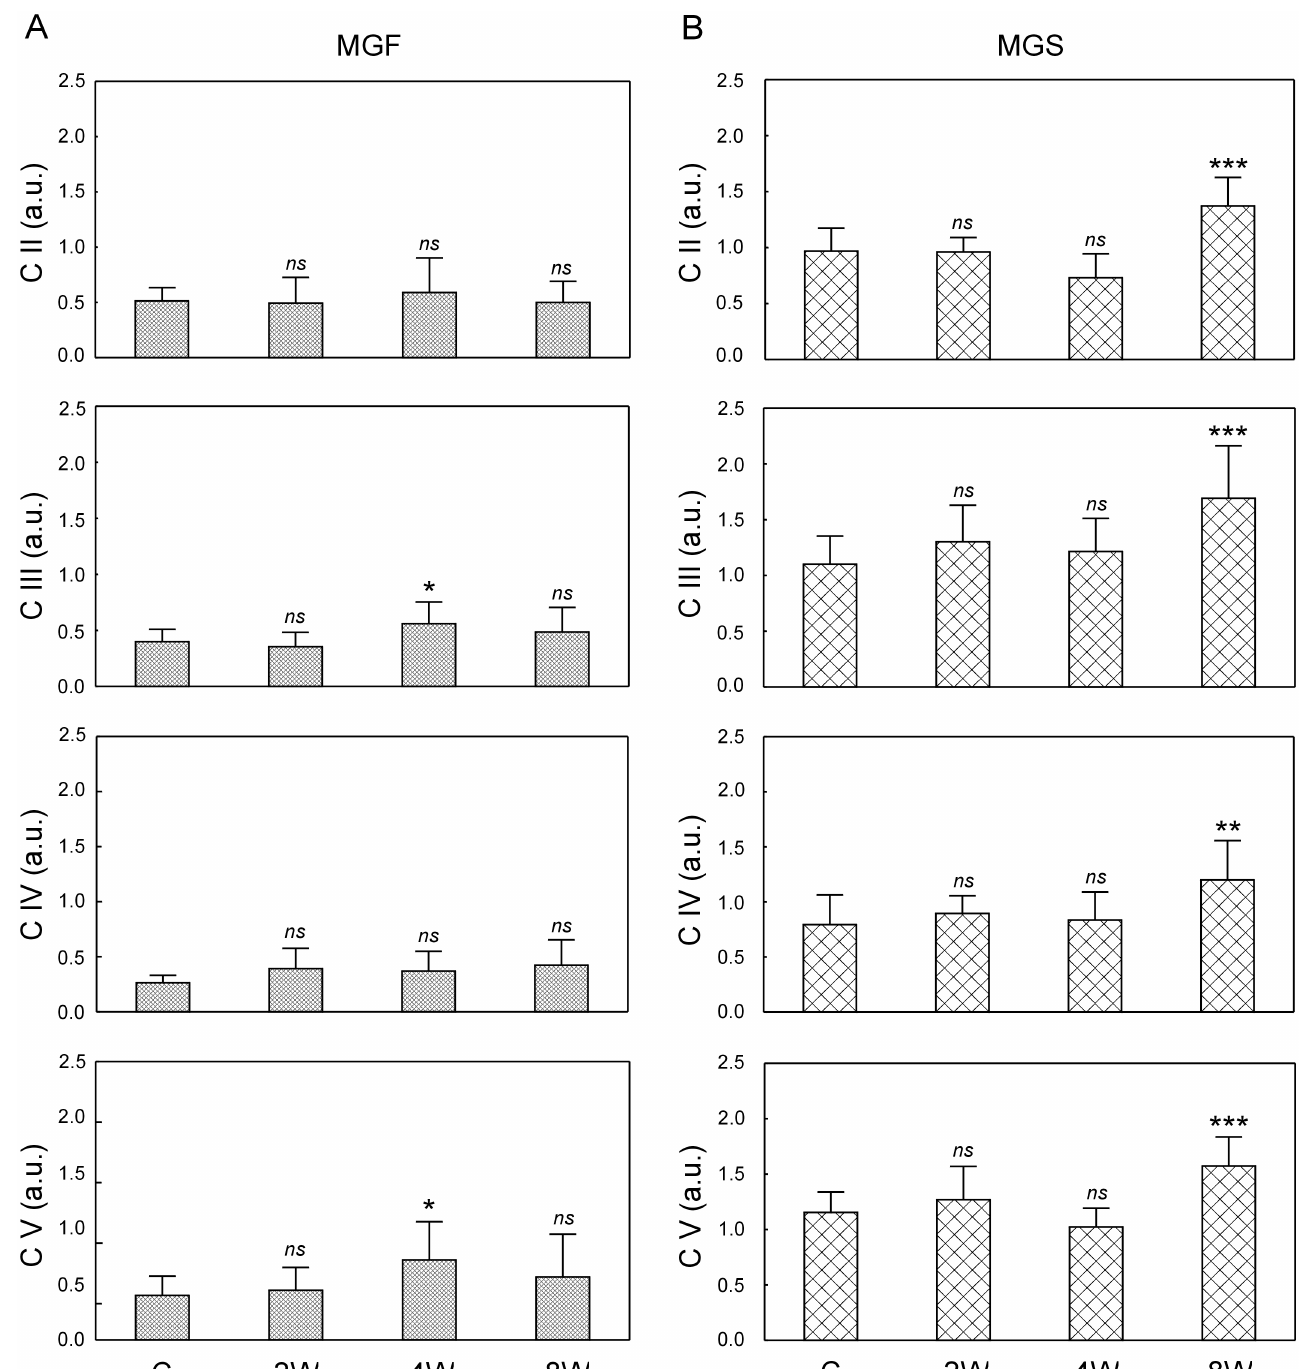
Fig 8. Mitochondrial protein ETC complexes in the MGF and the MGS in control and trained animals. Subunits of mitochondrial protein complexes (C II, C III, C IV, C V) in the fast part of the medial gastrocnemius muscle (MGF, panel A, S12 File) and in the slow part of the medial gastrocnemius (MGS, panel B, S13 File) after 2, 4 and 8 weeks of endurance training. Data are presented as mean + SD and normalized by the reference protein β -actin and the internal standard. One-sided p-value represents the statistical significance of the training period (2, 4 or 8 weeks) with respect to the control group (Dunnett’s post hoc test). The symbols (cid:3) denote values significantly different: (cid:3) p < 0.05, (cid:3)(cid:3) p < 0.01, (cid:3)(cid:3)(cid:3) p < 0.001.